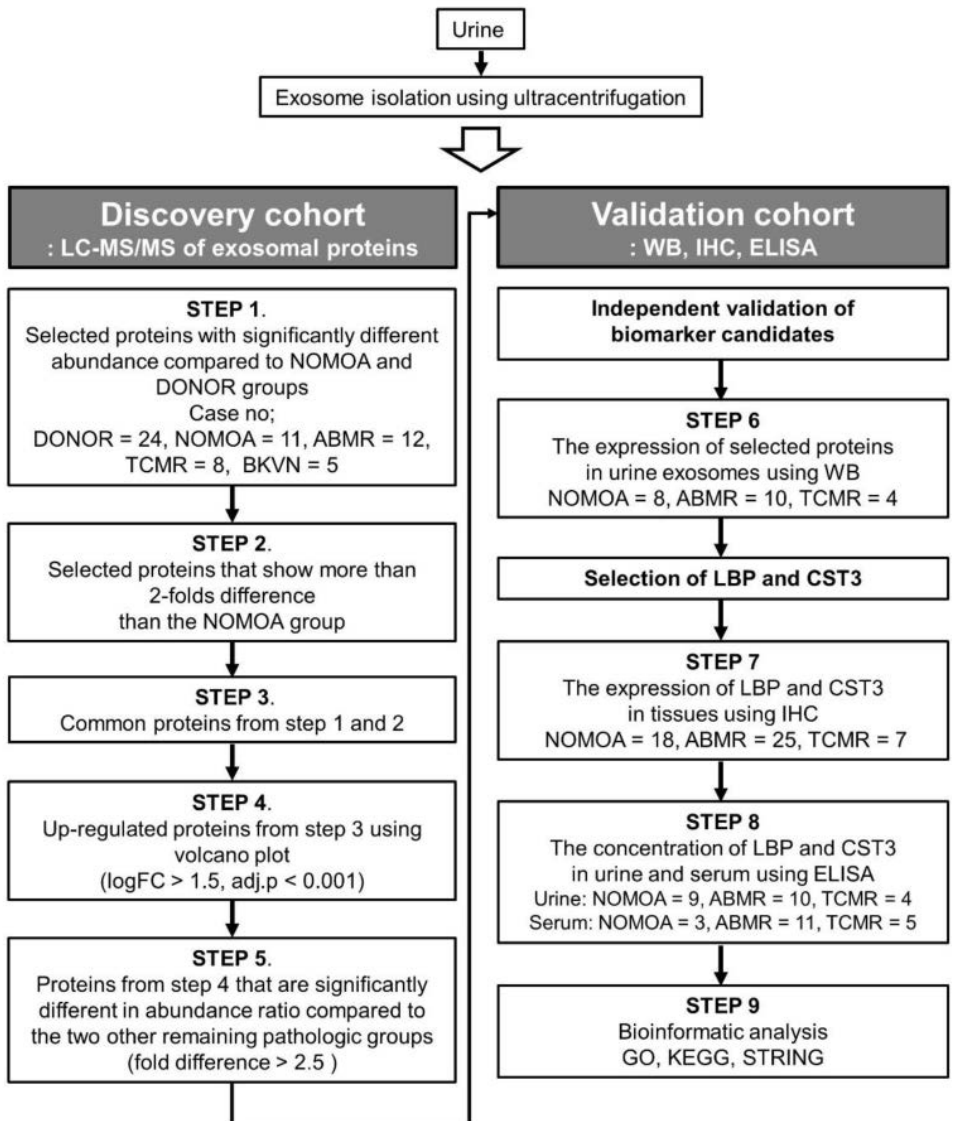
Figure 2. Study workflow for the discovery and validation of biomarkers representative of antibody- mediated rejection. LC-MS/MS, label-free liquid chromatography-mass spectrometry; ABMR, antibody-mediated rejection; TCMR, T-cell-mediated rejection; NOMOA, no major abnormality; BKVN, BK virus nephropathy; FC, fold change. WB, Western blot analysis; IHC, Immunohistochem- istry; ELISA, Enzyme linked immunosorbent assay; LBP, lipopolysaccharide-binding protein; CST3, Cystatin-C; KEGG, GO, Gene Ontology; Kyoto Encyclopedia of Genes and Genomes